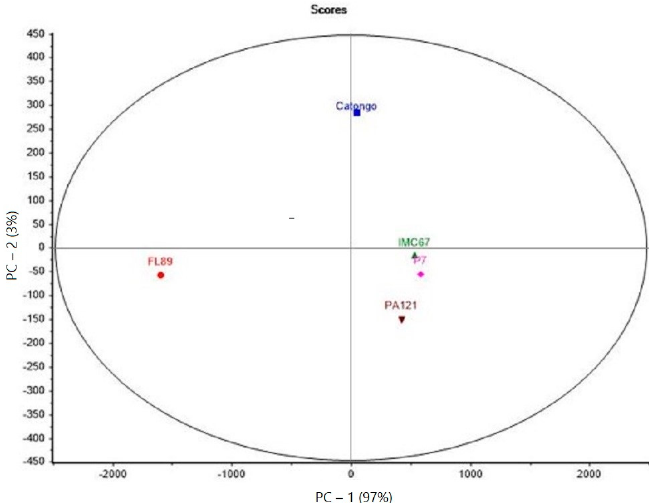
Figure 1. PCA of the five Brazilian cocoa genotypes.